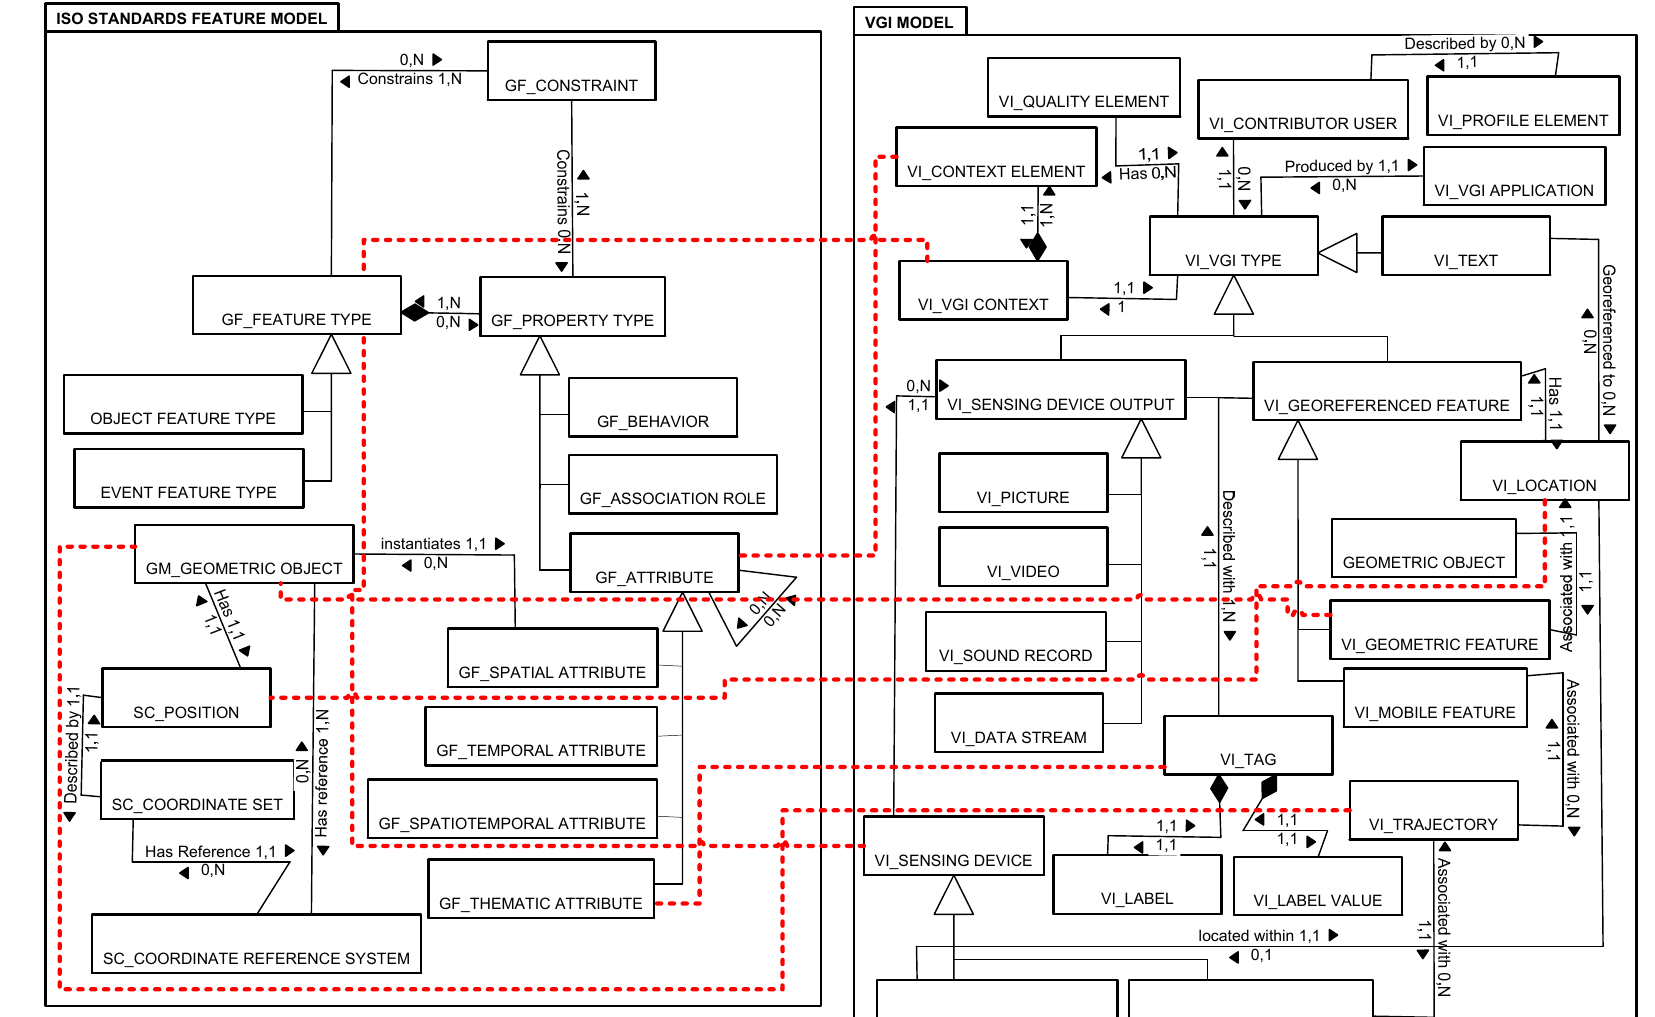
Figure 1. VGI Semantic Model and its relation with ISO 19100 series